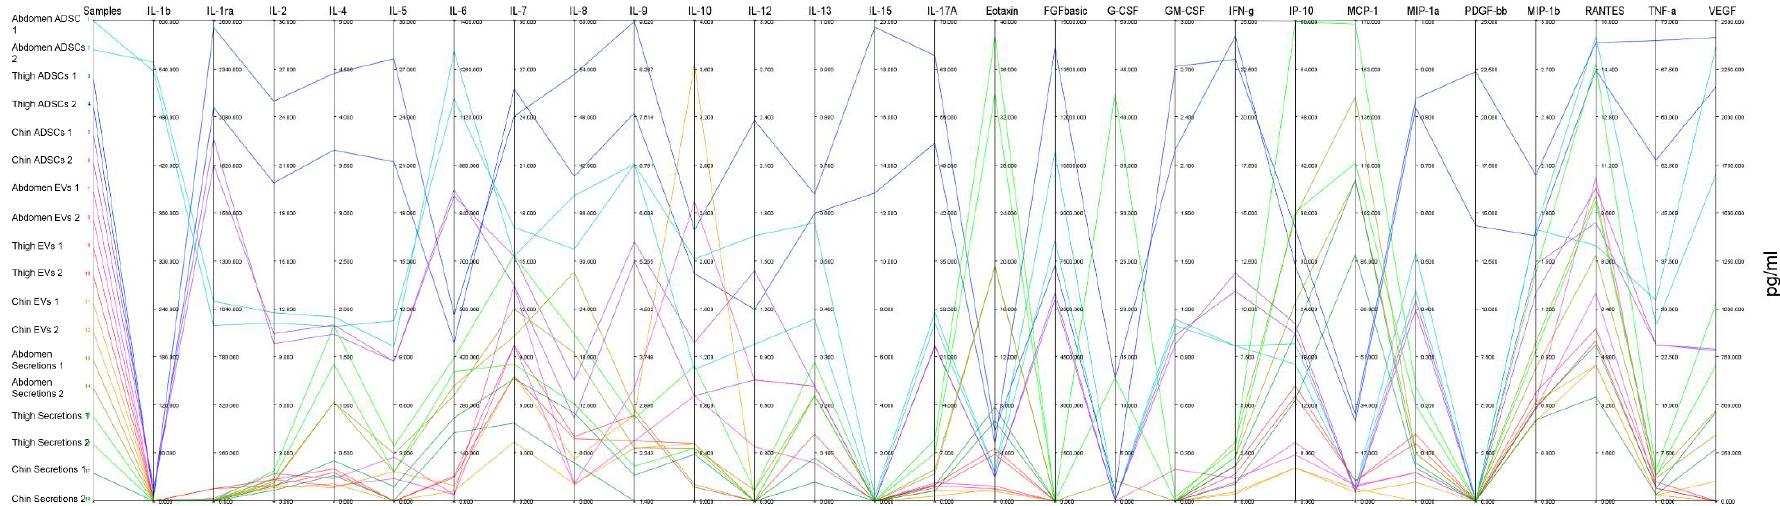
Figure 4. Parallel coordinates plot of Bioplex-27plex cytokine measure with all cytokines on unique linear y -axis and each sample denoted by coloured line travelling through its measured cytokine concentration in pg/mL. Abdomen ADSCs (turquoise), thigh ADSCs (blue), chin ADSCs (purple), abdomen EVs (pink), thigh EVs (orange), chin EVs (yellow), abdomen secretions (gold), thigh secretions (light green), chin secretions (dark green).